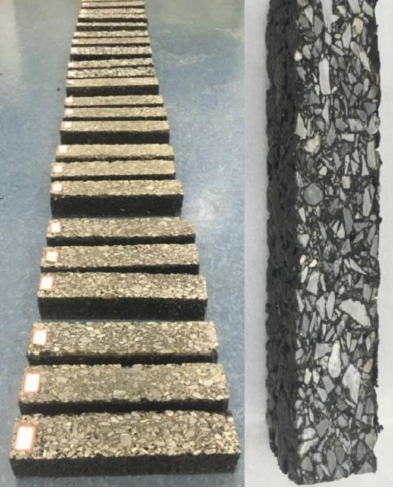
Figure 3. Beam-shaped specimens prepared for the fatigue